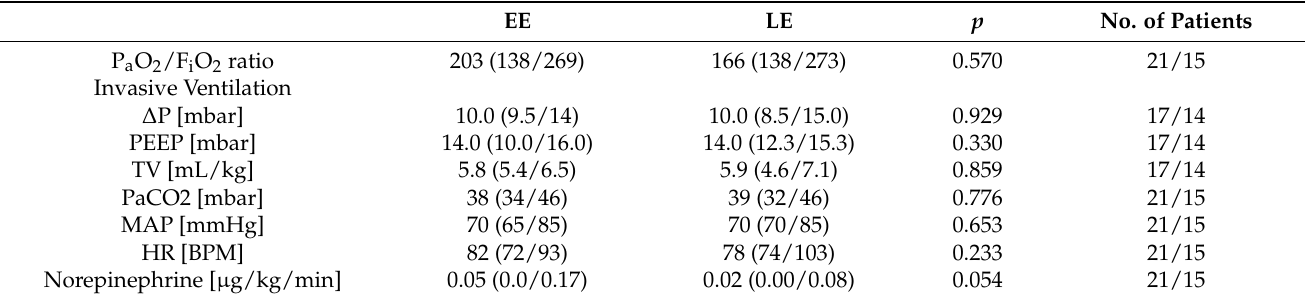
Table 3. Scores, respiratory/ventilatory and hemodynamic data obtained at EE and LE echocardiographic examination. EE LE p No. of Patients P a O 2 /F i O 2